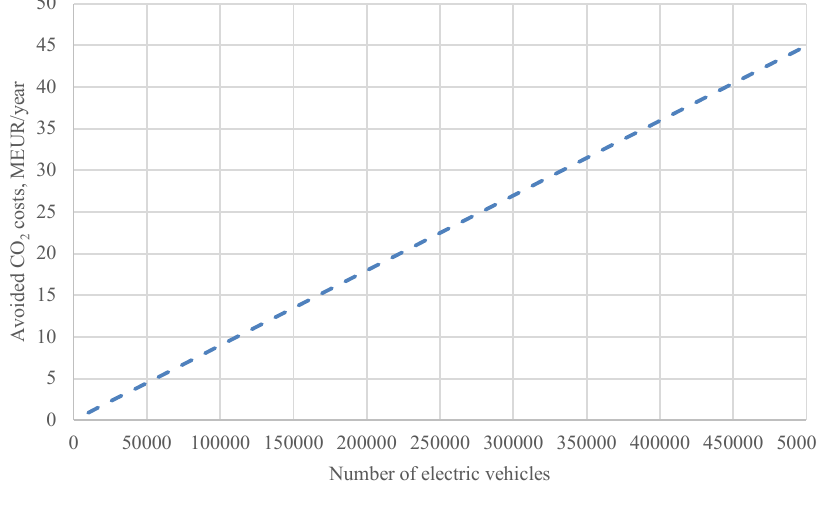
Fig. 2. Avoided CO 2 emission costs depending on number of electric vehicles in